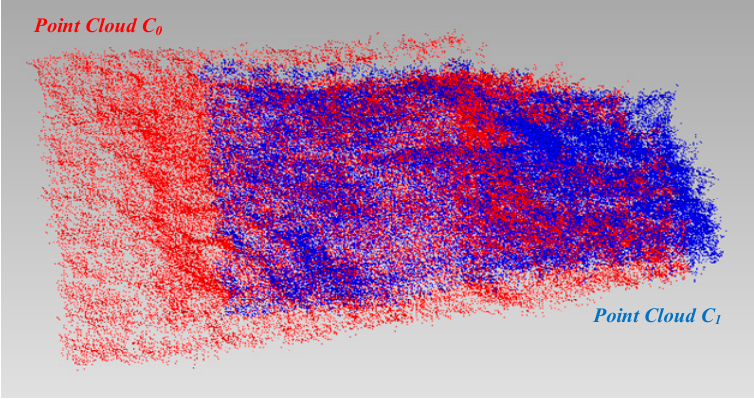
Figure 6. Registration result for the bi-temporal dense point clouds of the soil collection area.